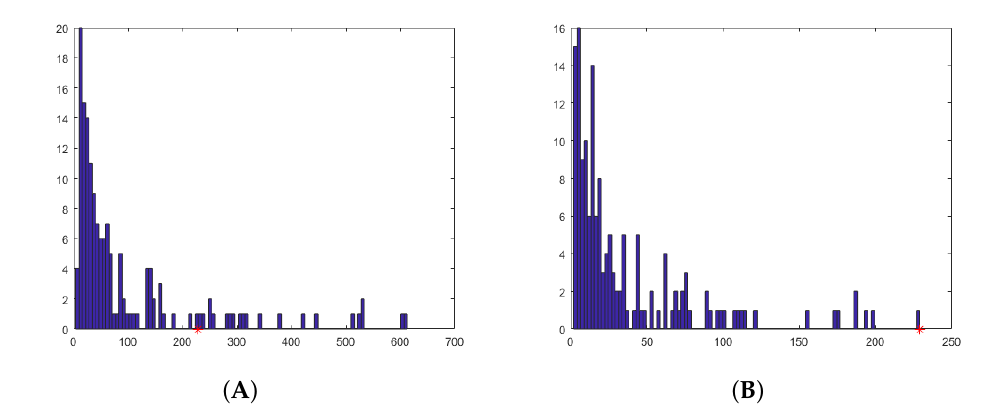
Figure 1. The distribution of the number of questions answered by each expert: ( A ) The frequency of forecasts per expert for all questions, and ( B ) The frequency of forecasts per expert for restricted to the 229 questions answered by the Australian Treasury.